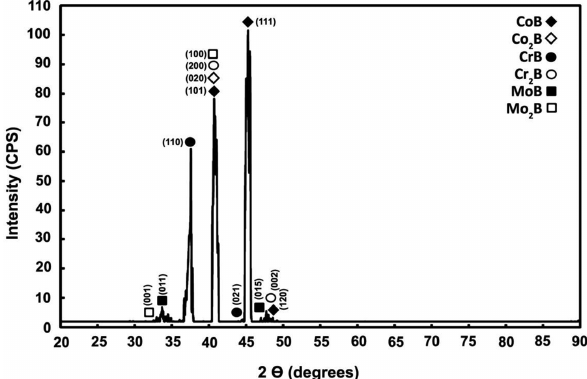
Figure 5: XRD pattern obtained on the borided CoCrMo alloy exposed to the anode. The PBDCF condition was 1148 K with 2 h of